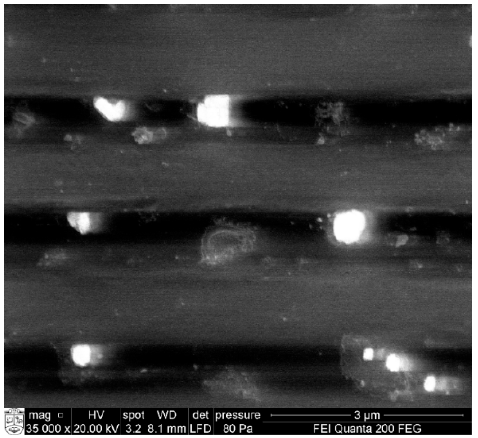
Figure 18. SEM image of bioparticles in motion.